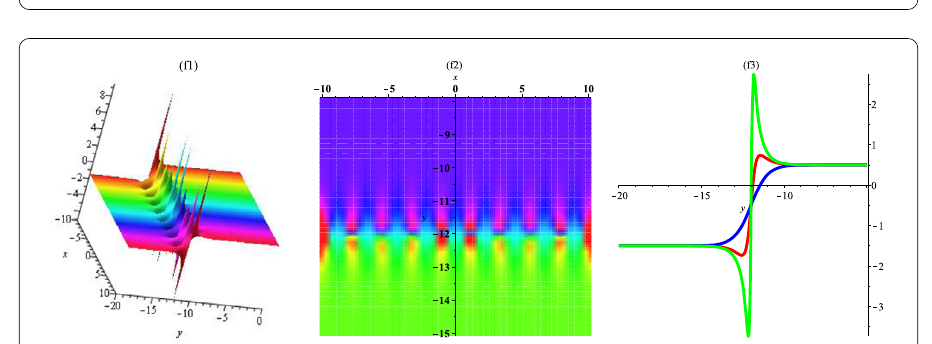
Figure 8 For solution of (3) u , v , w , c i = 1, t = 1, z = 0, (f1) 3D plot (f2) density plot and (f3) 2D plot with spaces x = –3,0,3